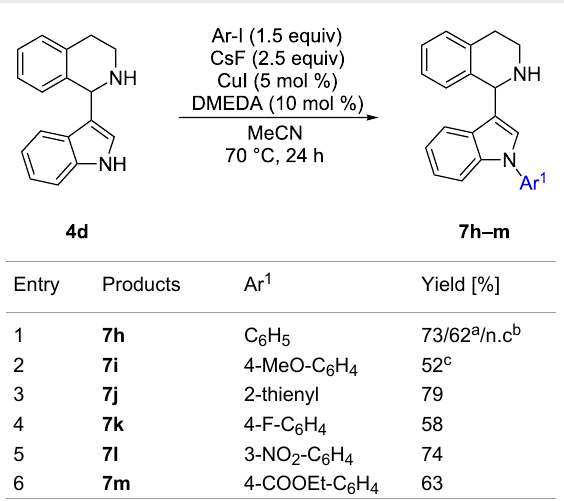
Table 4: CsF-mediated, copper-catalyzed regioselective